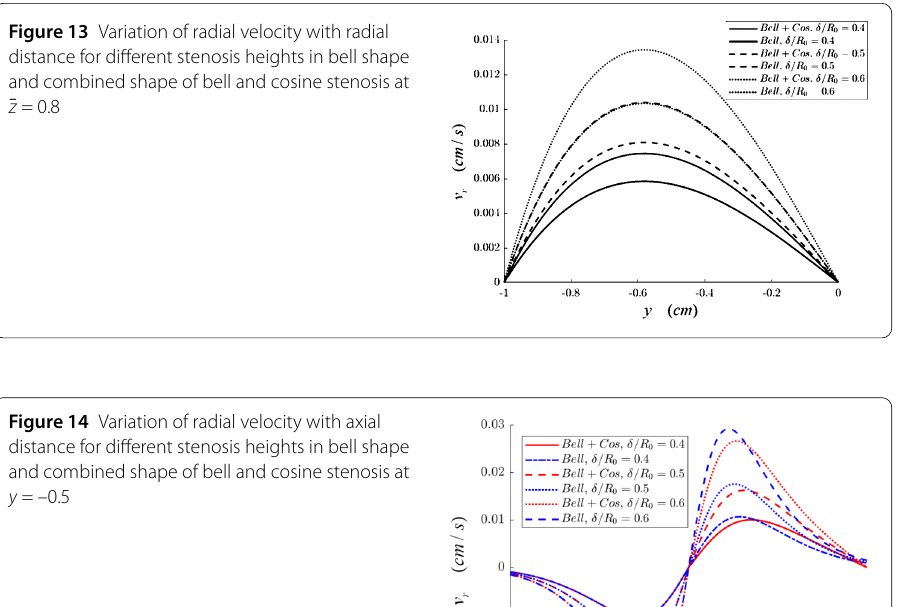
Figure 13 Variation of radial velocity with radial distance for different stenosis heights in bell shape and combined shape of bell and cosine stenosis at ¯ z = 0.8